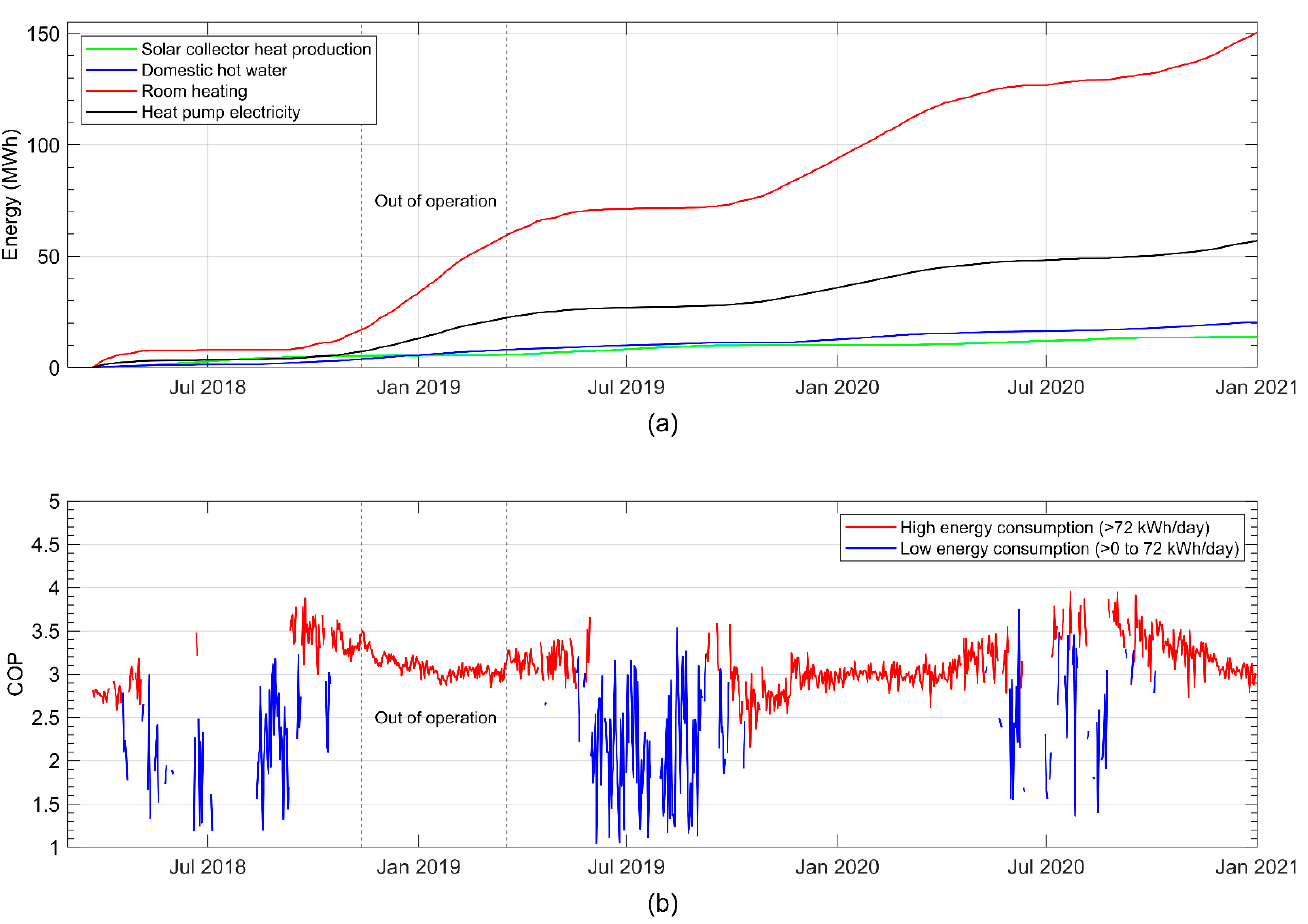
Figure 11. ( a ) Domestic hot water, room heating, and electricity consumption by the heat pump and solar collector heat production. ( b ) Daily averages of COP. “Out of operation” refers to the geothermal piping in the roadbed, not the GSHP, as the original ground collectors were used instead during this period.